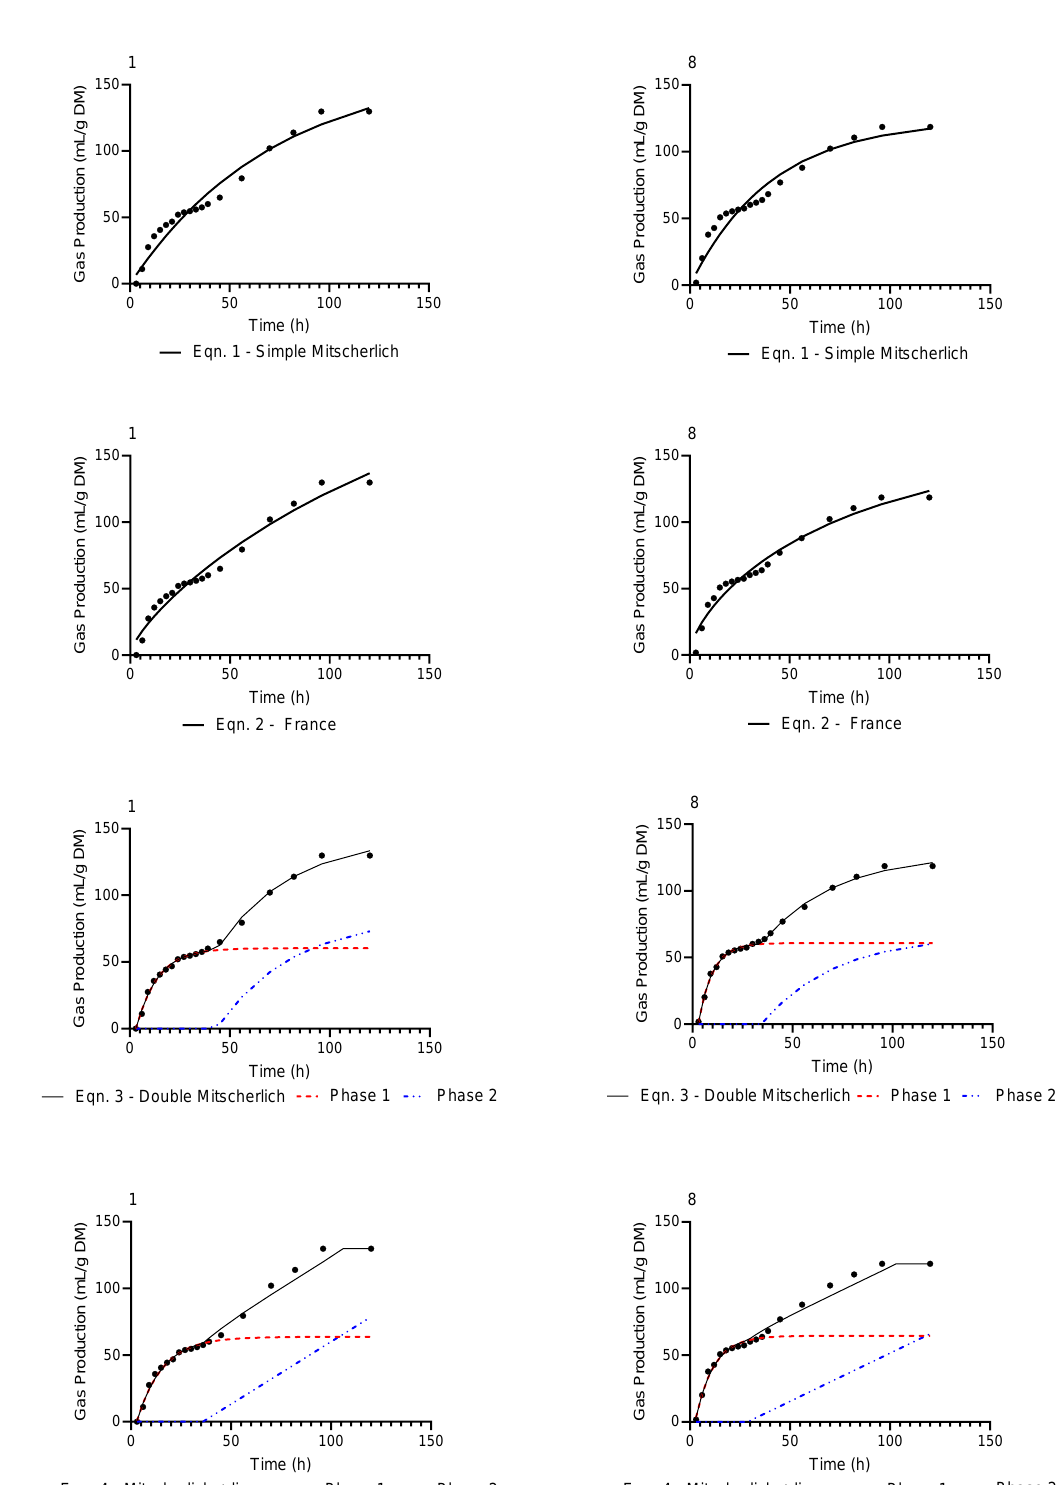
Figure 1. Observed (●) atypical gas production profiles and predicted curves resulting from fitting Equations (1) – (4) to Dataset 1 and 8 of Experiment 1.